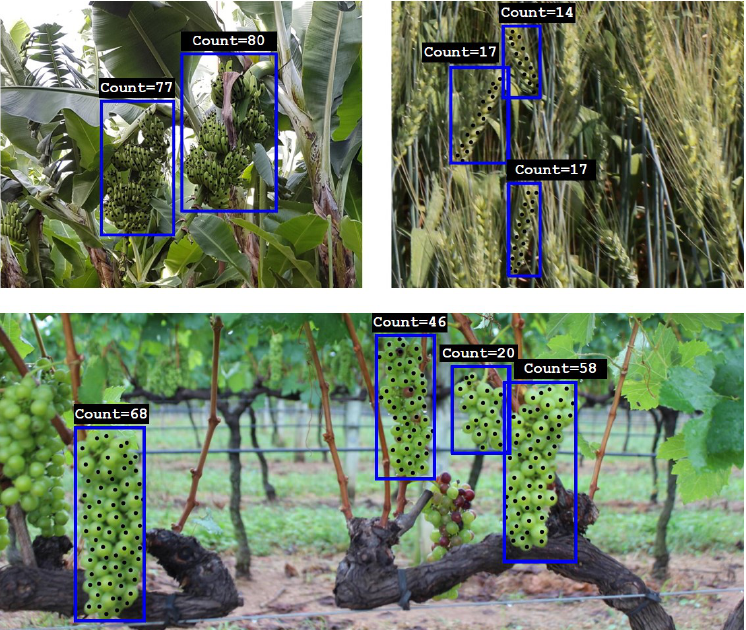
Figure 1. Example images with ground truth annotations. Top left: Bananas in banana bunches. Top right: Wheat spikelets in spikes. Bottom: Berries in grape bunches. Blue bounding boxes are placed around measurable objects. Black dots are placed on countable parts. The target count number (number of visible parts) is stated above each bounding